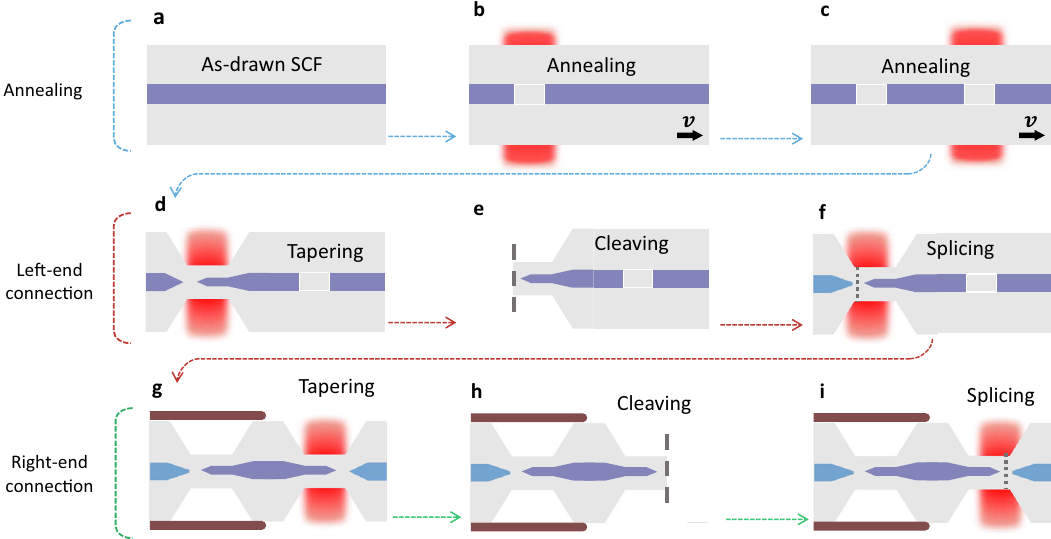
Fig. 1 Fabrication process fl ow of the all- fi bre heterogeneously-integrated parametric mixer. a Tapered SCF with core/cladding diameters of about 5 μ m/125 μ m. b Heating and tapering process to make the fi rst void gap in the fi bre core. c Heating and tapering to make the second void gap in the fi bre core. d Fibre tapering process to scale down core size and collapse the void gap to form the nano-spike coupler. e Cleave at the center of the void to remove one side of the taper. f Splice the SCF nanospike to a tapered SSMF. g Employ a polymer tube to mechanically support the SSMF-SCF connection, keeping the fi bre straight and tapering the other end of the SCF. h Cleave the other end and ( i ) splice to another tapered